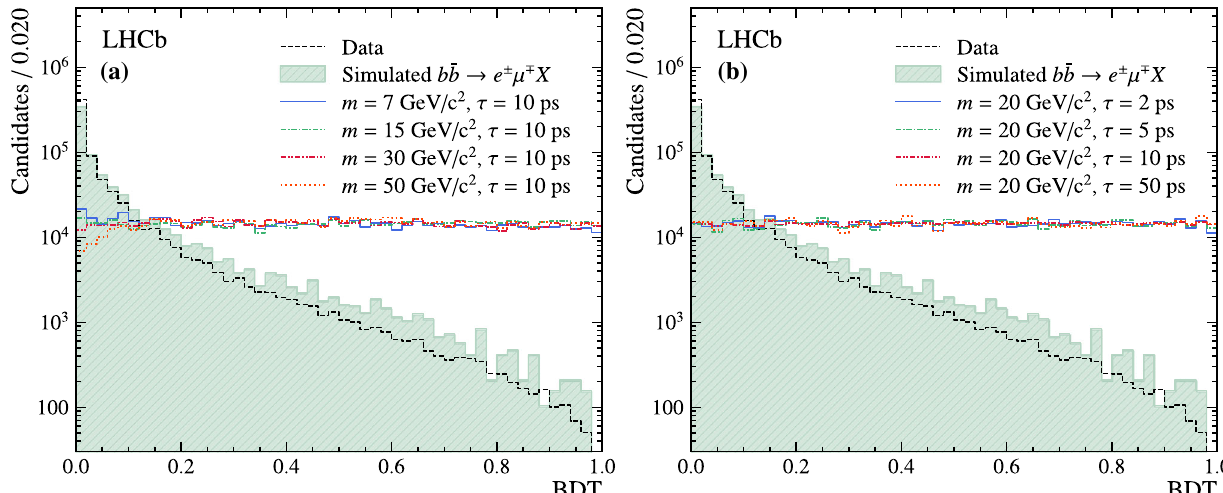
Fig. 3 Distribution of the BDT response in data (dashed black his- togram) compared to simulated bb → e ± μ ∓ X (green filled histogram) and LLP signal samples (coloured histograms) for different a m LLP and